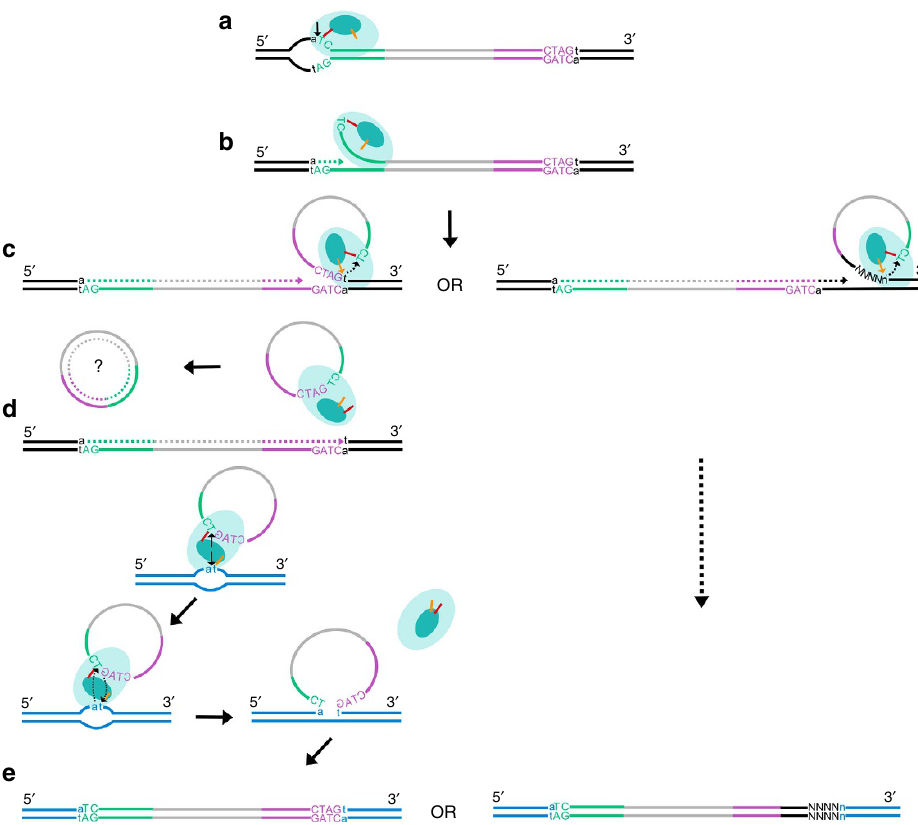
Figure 7 | Proposed model of Helraiser transposition. ( a ) Helraiser transposase (light blue oval) binds the LTS (green) and nicks ssDNA donor site generating a 5 0 -phosphotyrosine intermediate between the tyrosine residue (orange line) in the HUH nuclease active site (dark blue oval) and the transposon end. ( b ) A free 3 0 -OH group at the donor site primes DNA synthesis, while the helicase domain unwinds the dsDNA helix in a 5 0 to 3 0